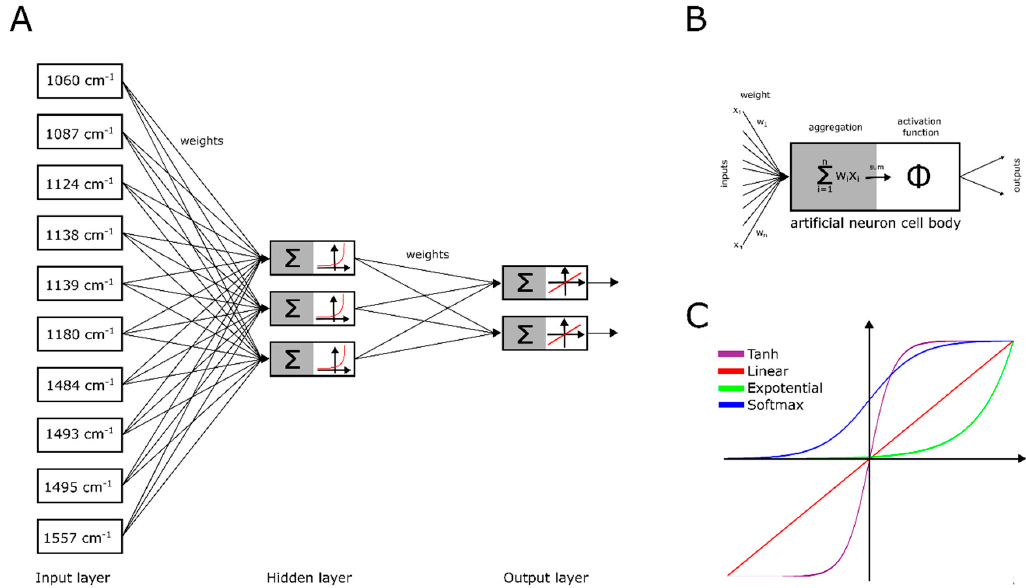
Figure 1. Artificial neural network topology based on the best network for detecting Helicobacter pylori infection. ( A ) Topology of an artificial neural network. ( B ) Detailed structure of an artificial neuron. ( C ) The most common activation functions of an artificial neuron.